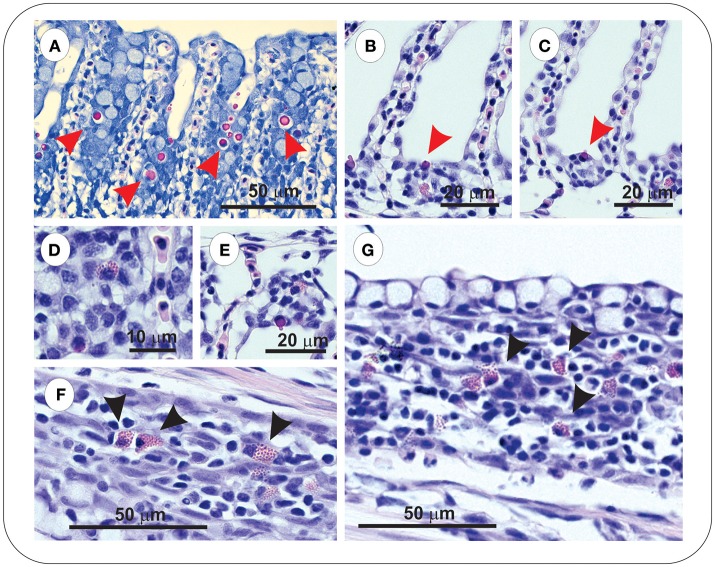
Gills of both unvaccinated and ForteMicro®-vaccinated charr were populated with sacciform cells (A–C), which stained bright pink (red arrowheads). A prominent feature specific to vaccinated Arctic charr gill was eosinophilic granular cells (EGCs, black arrowheads), which were observed associated with lamellar epithelia, and interlamellar spaces (D–G).